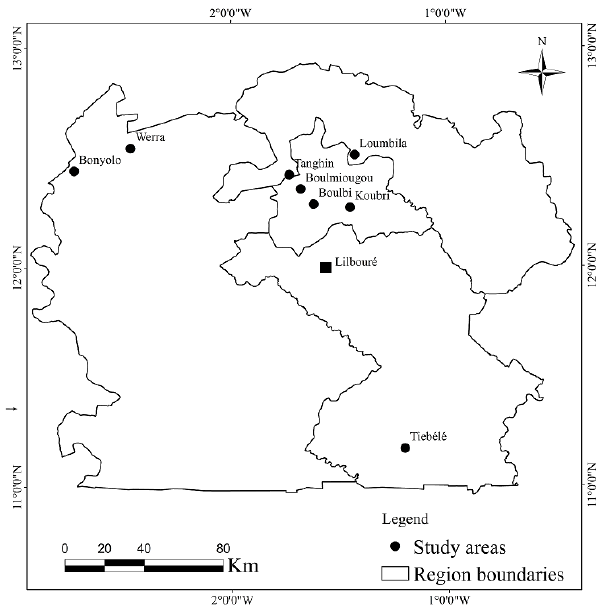
Figure 3. Sampling localities in Burkina Faso.Both prevalence of symbionts and phylogenetic analysis of Ca. Hemipteriphilus asiaticus were done on individuals from the nine localities indicated except Lilbouré (indicated by a square) for which no sample was used for the